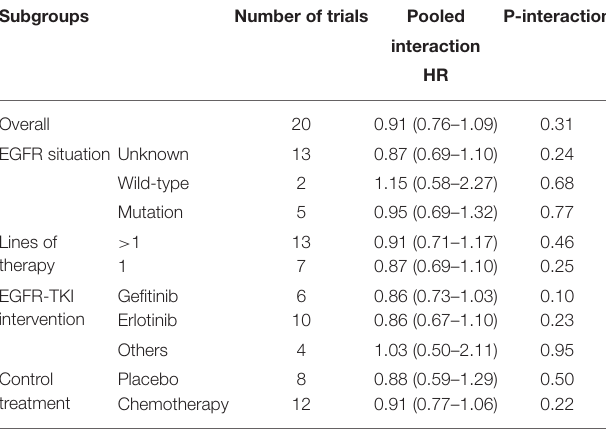
TABLE 2 | Differences in efficacy of EGFR-TKI therapy in females and males by subgroup. Subgroups Number of trials Pooled